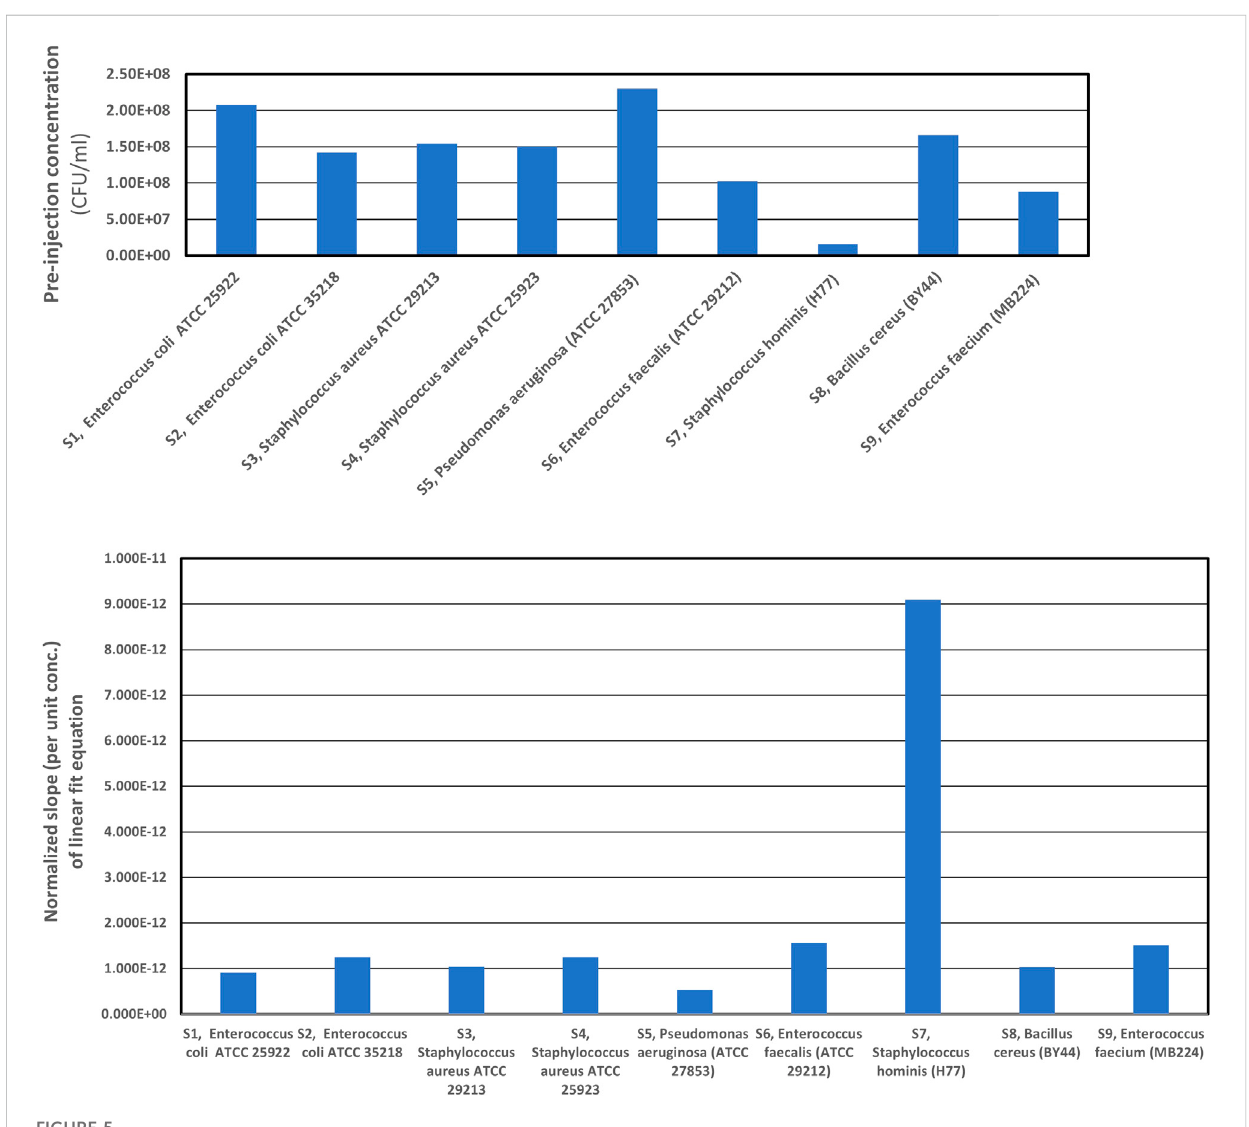
Normalized (per unit concentrations) linear slopes of the best fi t equations, from the back scattered intensity data for individual bacteria strains computed for 20 min trial runs. We observe that the normalized slopes per unit concentrations are different, for different strains having varied physical characteristics and concentrations. Therefore, one can infer that the relationship between best fi t equation ’ s normalized slope of backscattered light intensity data (see Table 4), the physical characteristics of different bacterial strains (scatterers) as well as the concentration of scatterers in the scattering volume of interrogation is imprinted in the optical back scatter information.